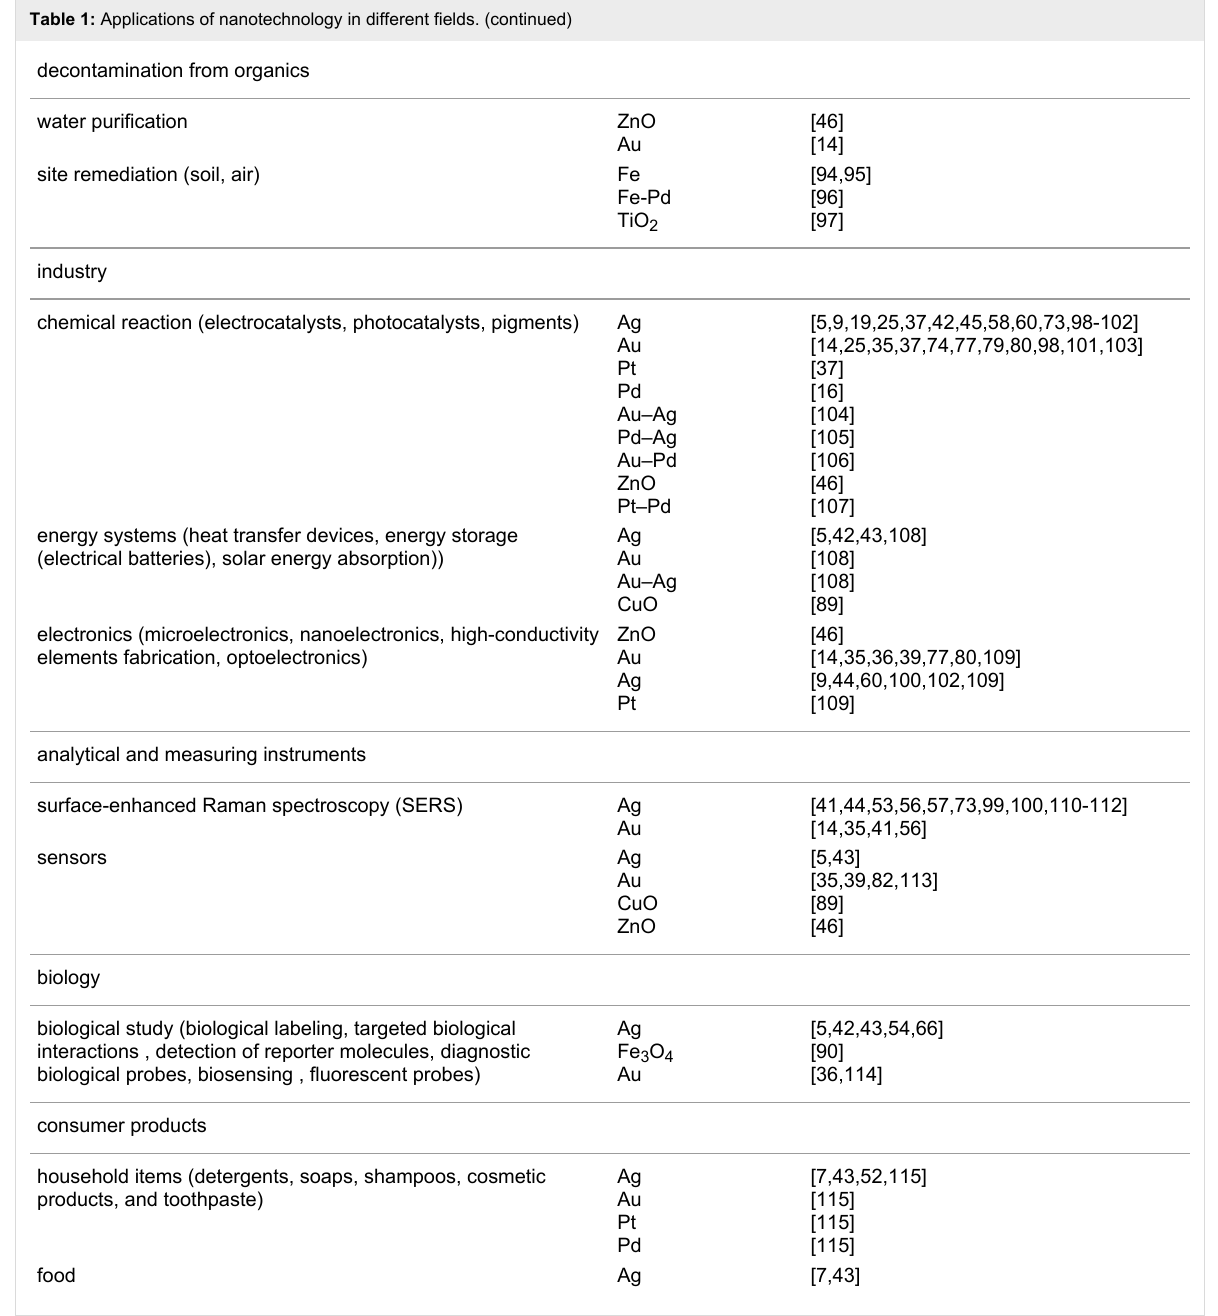
Table 1: Applications of nanotechnology in different fields. (continued) decontamination from